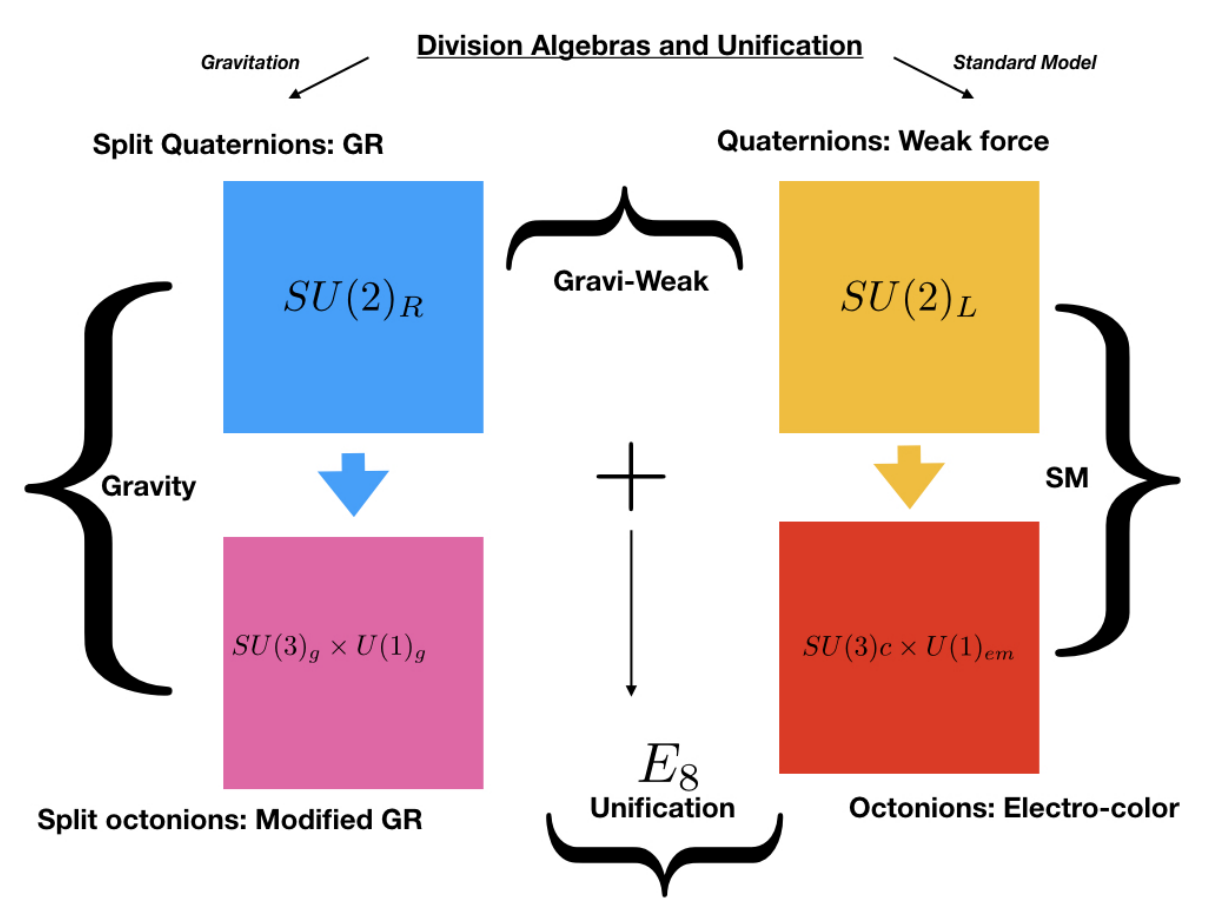
Figure 3. Octonions, and an E 8 × E 8 unification of standard model and pre-gravitation [18]. Here, ‘GR’ stays for ‘general relativity’, ‘SM’ stays for ‘standard